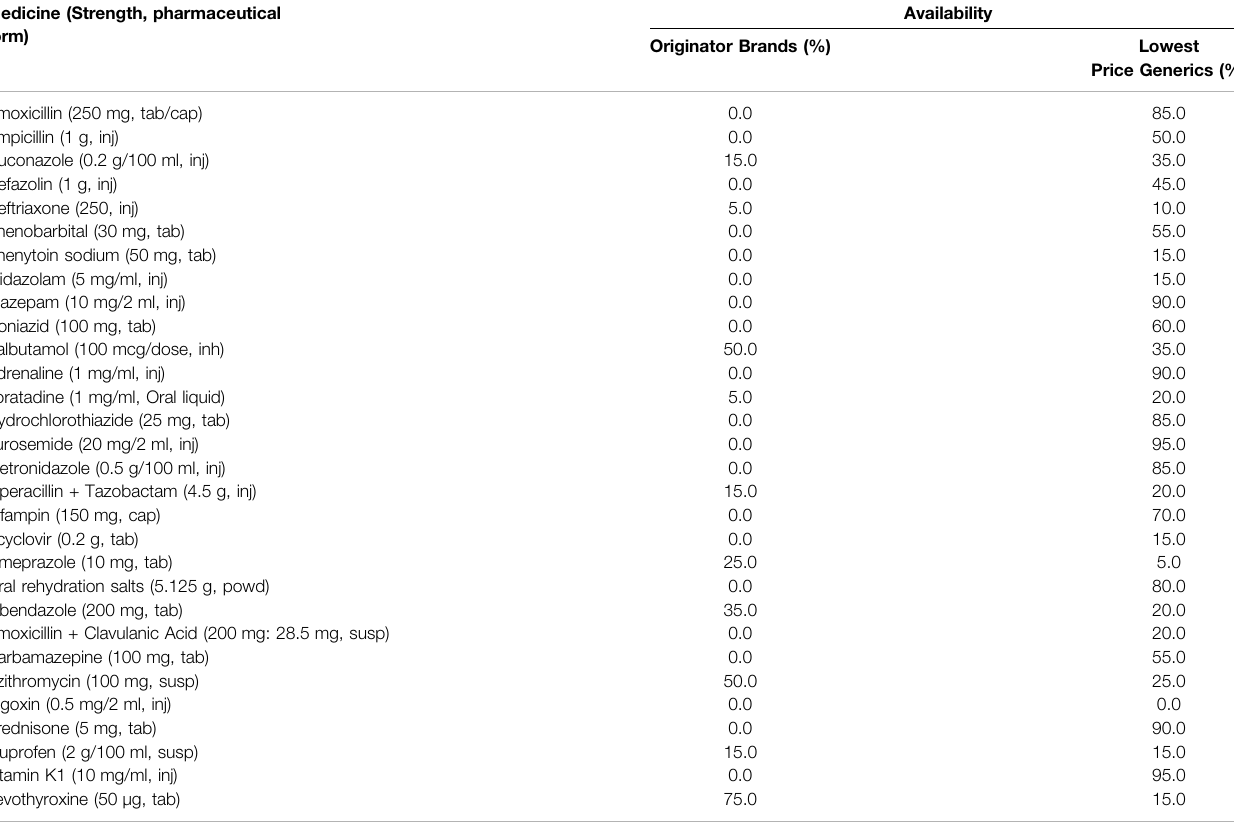
TABLE 3 | Availability of individual medicines for children. Medicine (Strength, pharmaceutical form)